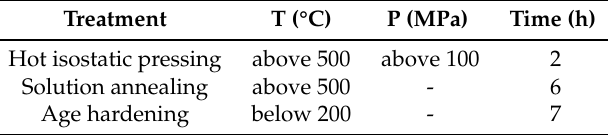
Table 1. Parameter of subsequent post treatments.